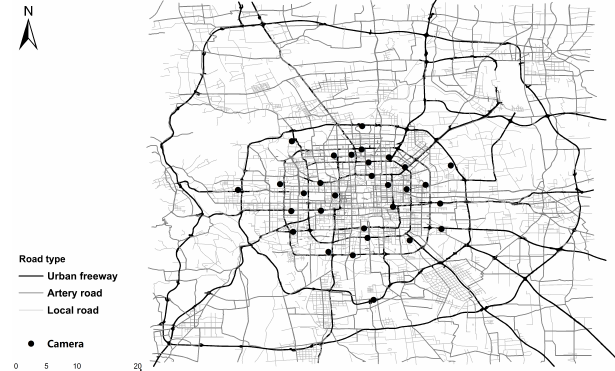
Figure 2. Point location of video